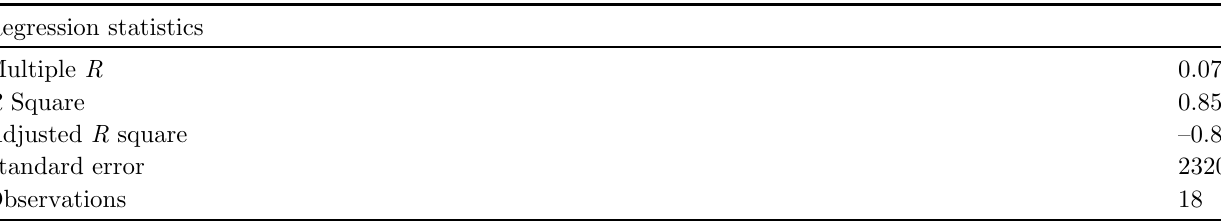
Table 8. Regression